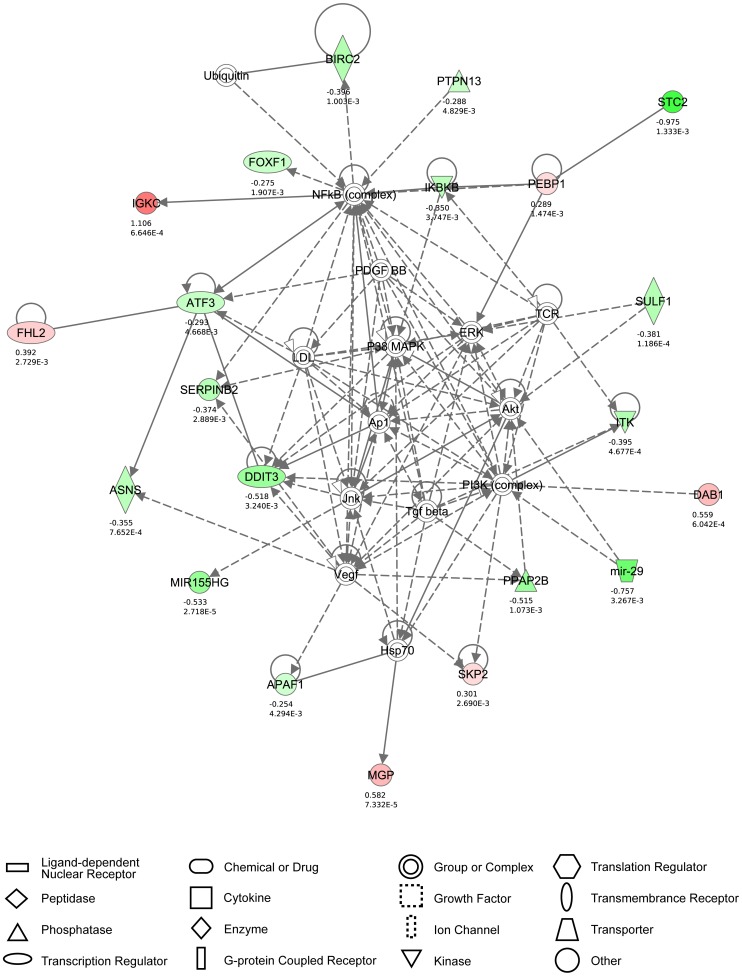
Cell death is the principal high-dose AA-modulated molecular network in MT-2 cells.The networks were generated through the use of IPA (Ingenuity® Systems, www.ingenuity.com), based on genes regulated by high-dose AA treatment in MT-2 cells (after 48 hours of culture). The principal molecular network is graphically displayed, identified as cell death. The red and green colour indicate up- or down-regulation, respectively, with the intensity indicating the degree of the gene transcription change. The log2 fold-change values and p-values are indicated below each molecule. Network shapes are represented in the legend. Full lines represent direct interactions, while dashed lines indirect interactions.